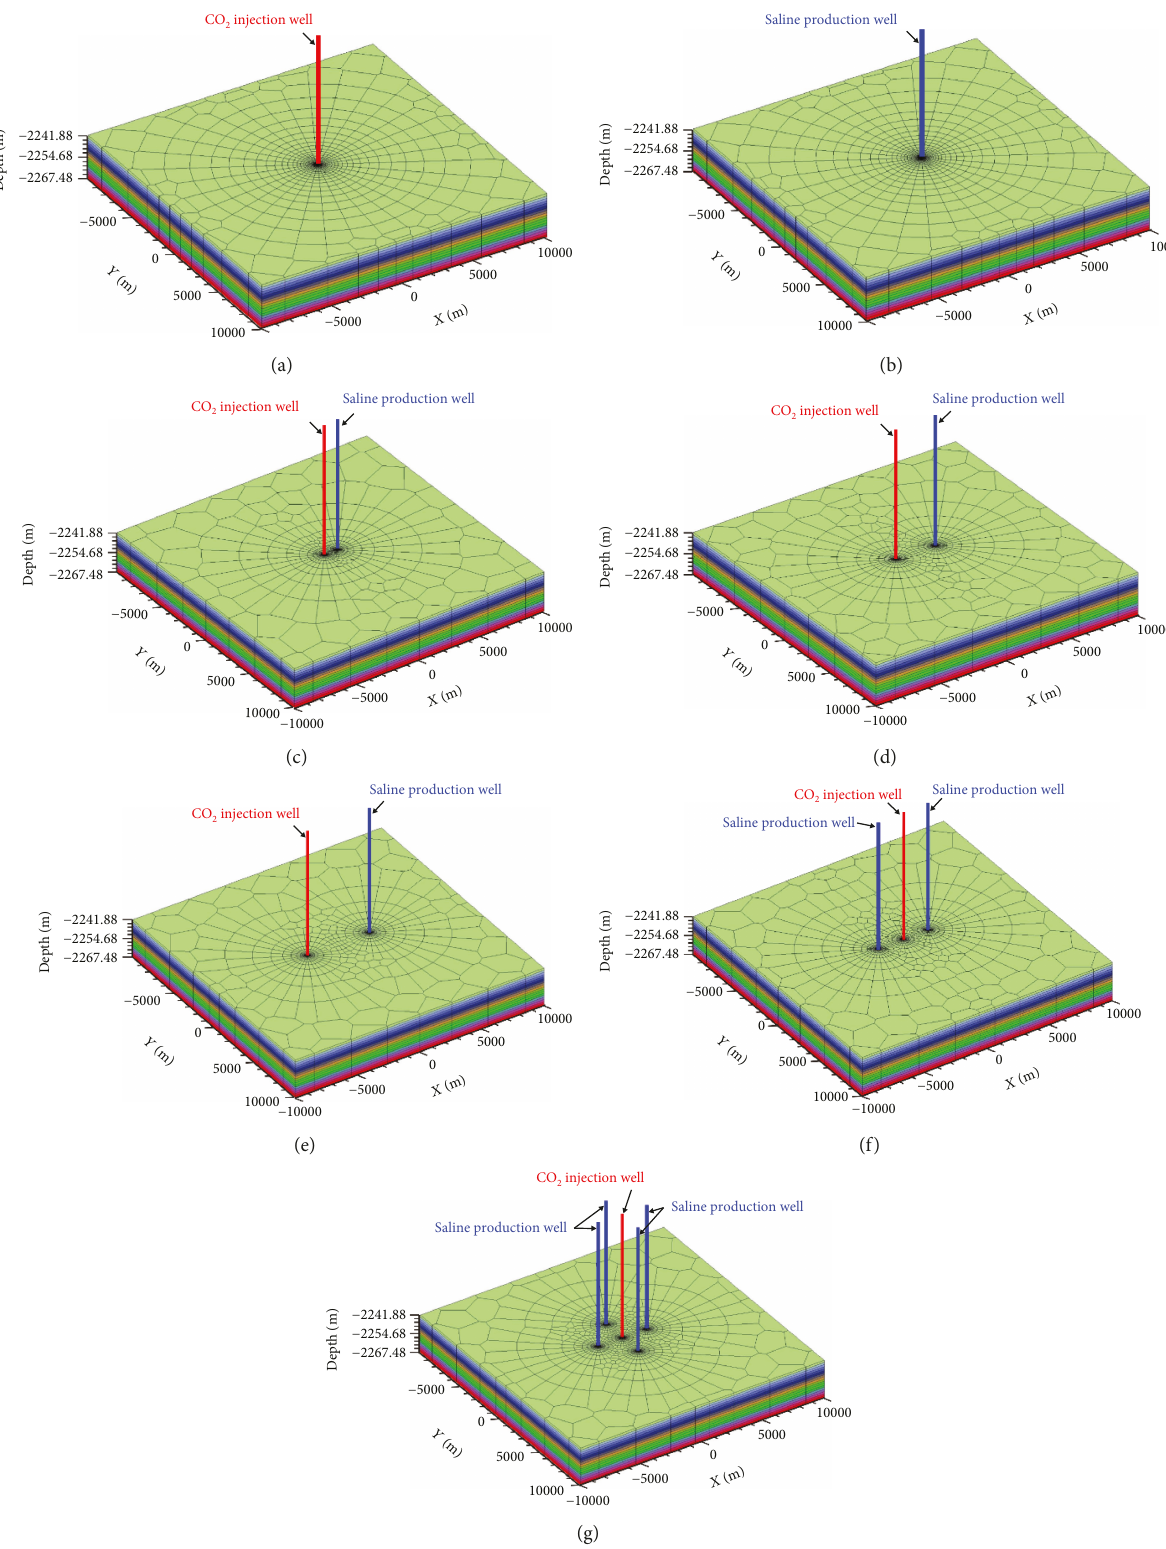
Figure 4: The 3D grid for the simulation scenarios. (a) Sole CO injection. (b) Sole water production. (c) 1 injection well and 1 production 2 well with the well spacing of 1km. (d) 1 injection well and 1 production well with the well spacing of 3km. (e) 1 injection well and 1 production well with the well spacing of 5km. (f) 1 injection well and 2 production wells with the well spacing of 2km. (g) 1 injection well and 4 production wells with the well spacing of